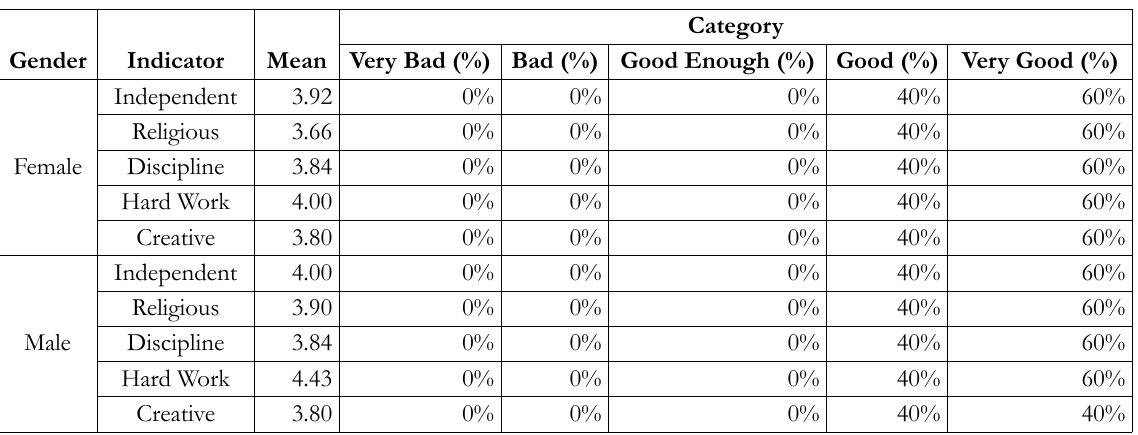
Table 14. Character Description of Eighth Grade Students based on Student Character Indicators Gender